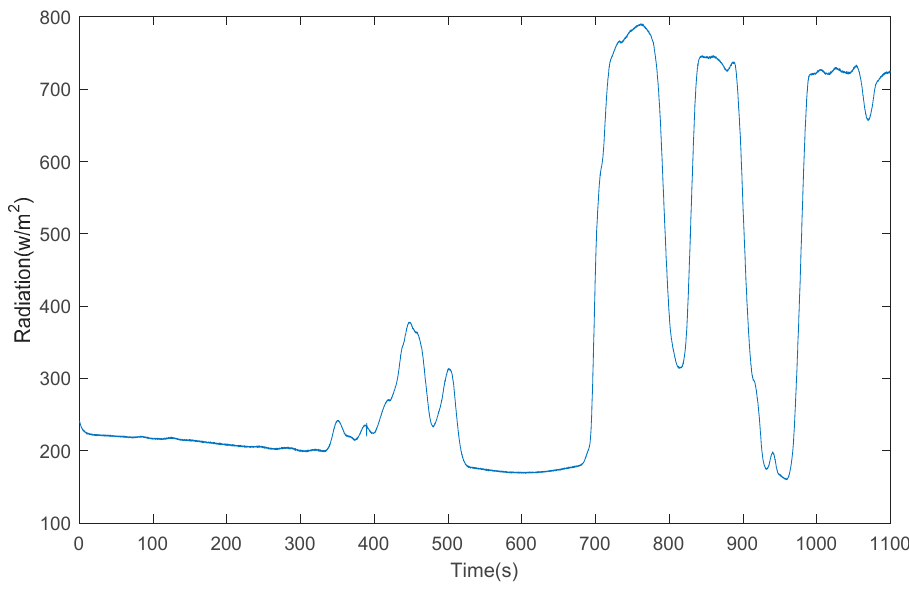
Figure 17. Measured solar radiation. The input and output voltages for the proposed coupled inductor topology are shown in Figure 18 whereas the coil and load current are presented in Figure 19.